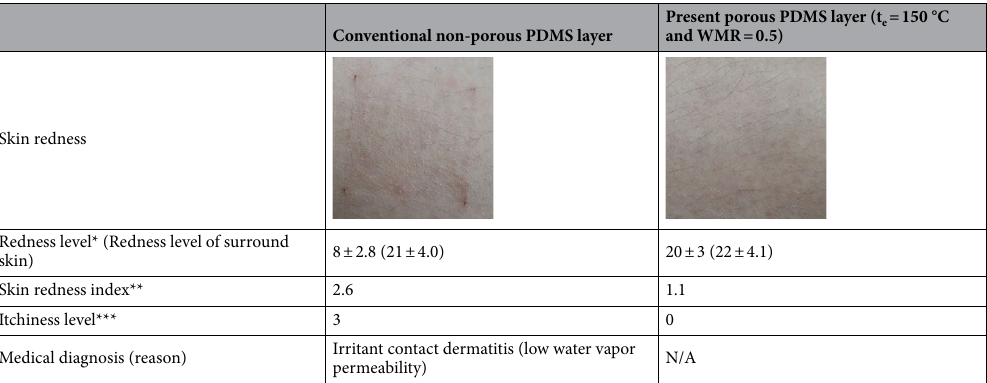
Table 4. Human skin attachment test of the conventional and present porous PDMS layer. *Redness level is measured on 6 spots of each specimen with HSL color code (0: red, 25: yellow). **Skin redness index = Redness level of the specimen attached skin / Redness level of surround skin. ***Itchiness level survey (0: normal state, 6: mosquito biting. All results are measured followed by 7 days of the specimens attachment on 1